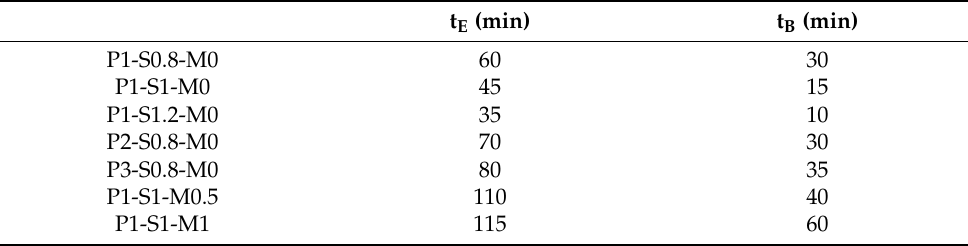
Table 4. The t E and t B of 3D-AAFS mortars.